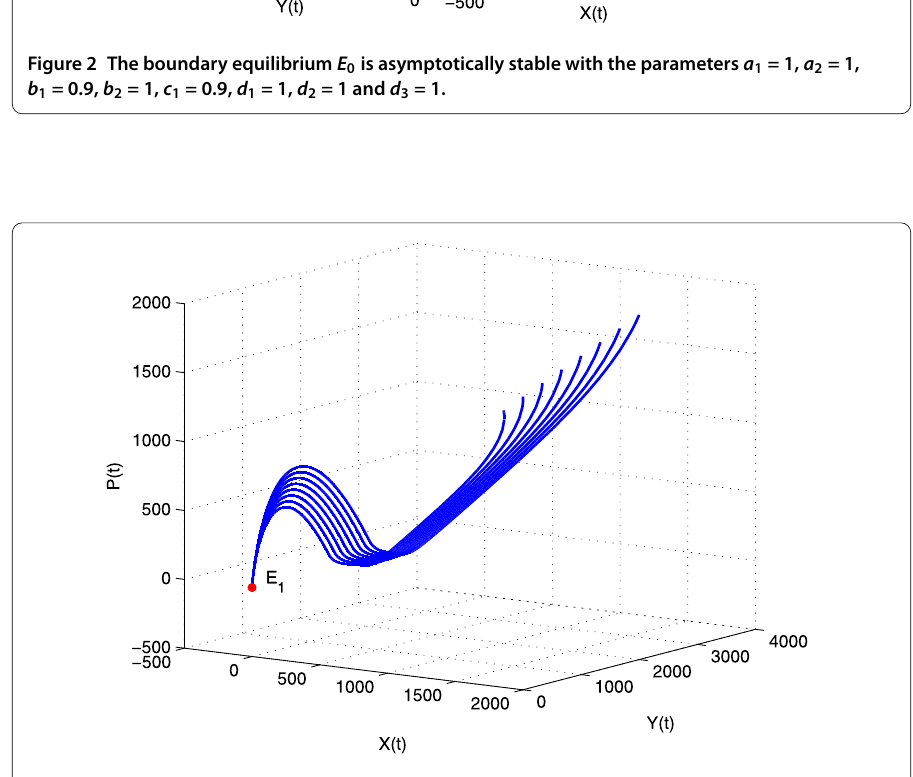
Figure 3 The boundary equilibrium E 1 is locally asymptotically stable with the parameters a 1 = 1, a 2 = 1, b 1 = 1.5, b 2 = 1, c 1 = 0.7, d 1 = 1, d 2 = 1 and d 3 = 1.